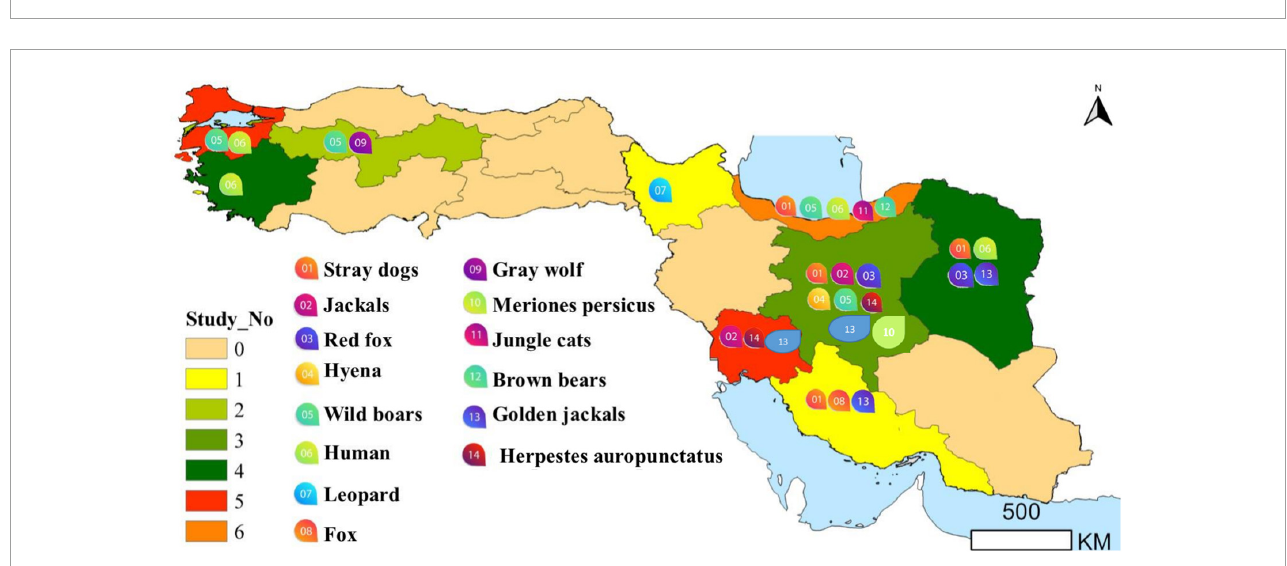
FIGURE1 Geographical districts of Iran and Turkey.